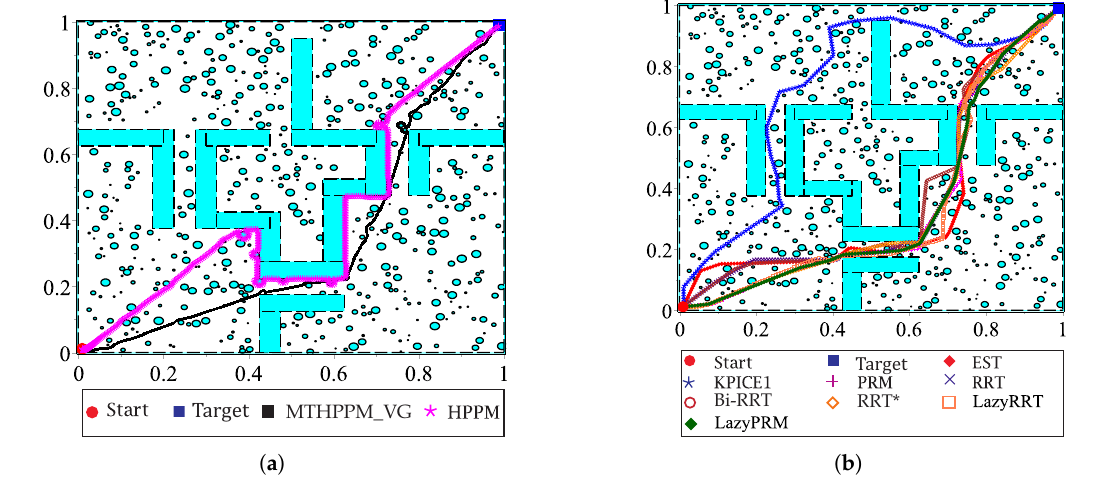
Figure 17. Visual comparative between MTHPPM and HPPM against best run of each SBP algorithm for case study 1. ( a ) Paths obtained with HPPM and MTHPPM_VG. ( b ) Paths obtained with SBP